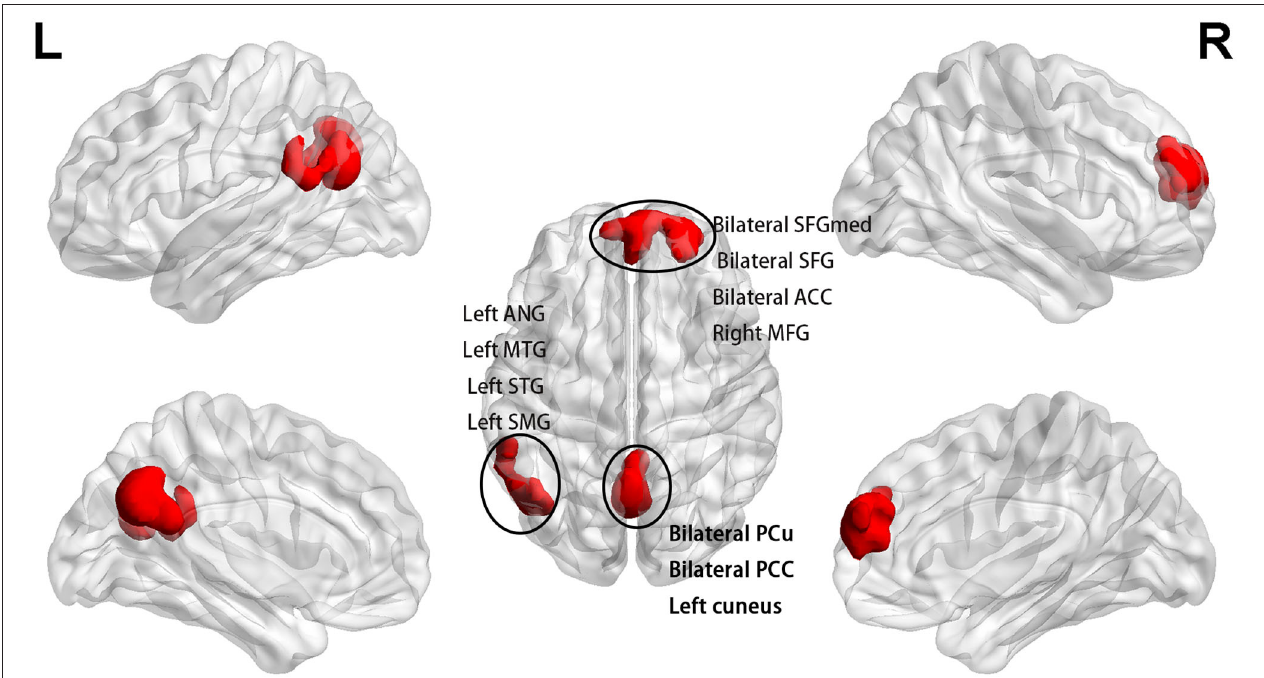
FIGURE 3 | After treatment, fALFF increased in bilateral SFGmed, bilateral SFG, bilateral ACC, and right MFG (cluster D); bilateral PCu, bilateral PCC, and left cuneus (cluster E); and left ANG, left MTG, left STG, and left SMG (cluster F) in comparison with the baseline of the patients in the slow 5 band ( p < 0.025, FWE corrected, CZ = 100). SFG, superior frontal gyrus; MFG, middle frontal gyrus; ANG, angular; MTG, middle temporal gyrus; STG, superior temporal gyrus; SMG, supramarginal gyrus.